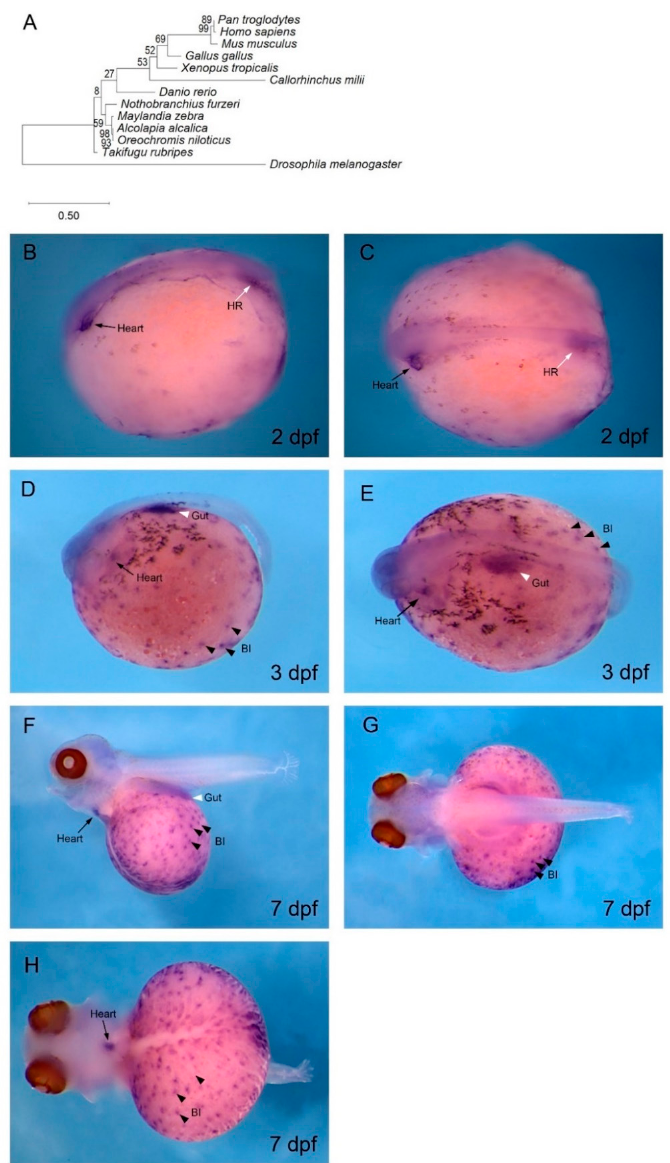
Figure 2. gata4 is expressed in cardiac and vascular regions of O. alcalica embryos. ( A ) Phylogenetic analysis of GATA4. The evolutionary history was inferred using the maximum likelihood method and Dayhoff with frequency model and gamma distribution [58]. ( B – H ) In situ hybridisation of O. alcalica gata4 at 2 days post fertilisation (dpf) ( B , C ), 3 dpf ( D , E ), and 7 dpf ( F – H ). At 2 dpf, Oa gata4 was expressed in the heart and haematopoietic region (HR) ( B , C ). At 3 dpf and 7 dpf, Oa gata4 was expressed in the heart, gut, and blood islands (BI) ( D – H ). At 7 dpf, embryos were bleached to remove melanocyte pigmentation ( F – H ). Black arrows denote the heart, black arrowheads mark blood islands (BI), white arrows denote the haematopoietic region (HR), and white arrowheads mark the gut. ( B , D , F ) Lateral views; anterior to the left. ( C , E , G ) Dorsal views; anterior to the left. ( H ) Anterior view; dorsal to the left.